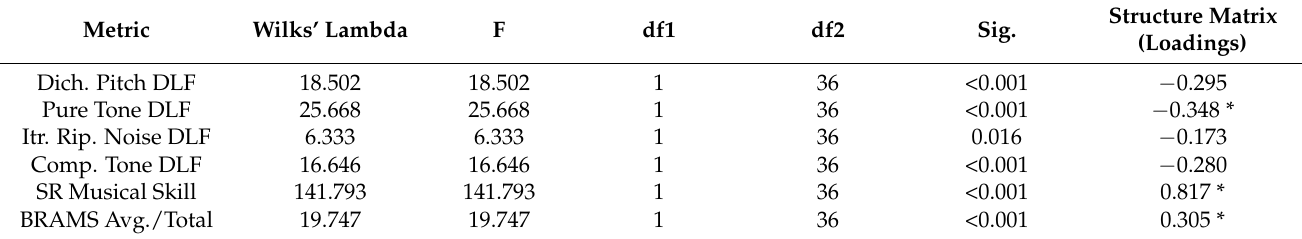
Figure 3. Scatterplots of individual data for musicians (red) and non-musicians (black) with regression lines. Left column shows relationships between pitch discrimination thresholds self-reported (subjective) musical skill (scaled between 1–9, with 1 being novice, 9 professional). Higher self-report is associated with smaller (better) thresholds. Right column shows relationships between pitch discrimination thresholds behavioral scores obtained from the BRAMS musical skills test (objective). Higher score is associated with smaller (better) thresholds. Table 2. Discriminant analysis results including tests of equality of group means and variable